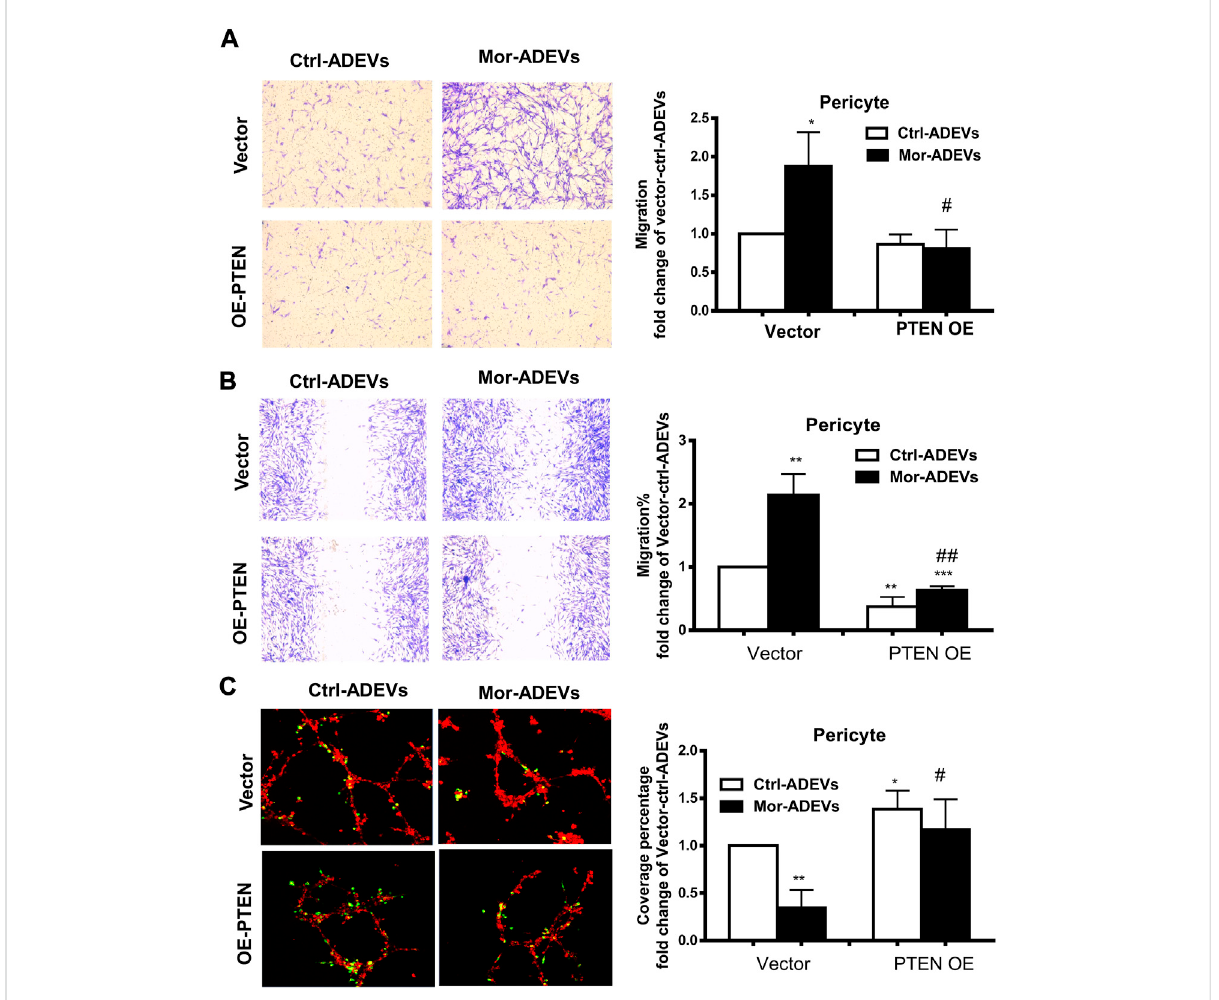
FIGURE 7 OverexpressionofPTENattenuatesmorphine-ADEV-mediated pericyte migration. (A – C) Pericytes weretransfectedwith either control vector orPTENoverexpression plasmid (PTENOE)for24 h,thenexposedtoeither control-ADEVs ormorphine-ADEVs.Thenthemigrationofpericyte was measured by transwell migration assay (A) . The representative images of migratory pericytes stained with crystal violet. Scale bar = 100 µm. The migration of pericyte was measured by the scratch assay (B) . The representative images of pericytes stained with crystal violet and then the representative images were analyzed by ImageJ software. Scale bars, 100 μ m. Loss of pericyte was measured by 3D pericyte (green)-endothelia (Red)coculturemodel (C) ,andthentherepresentativeimageswereanalyzedbyImageJ.Scalebars,50 μ m.Alldataarepresentedasmean±SD,* p < 0.05, *** p < 0.01 vs. control group (Vector-CTL-ADEVs), # p < 0.05, ## p < 0.01 vs. Vector-morphine-ADEVs group using one-way ANOVA